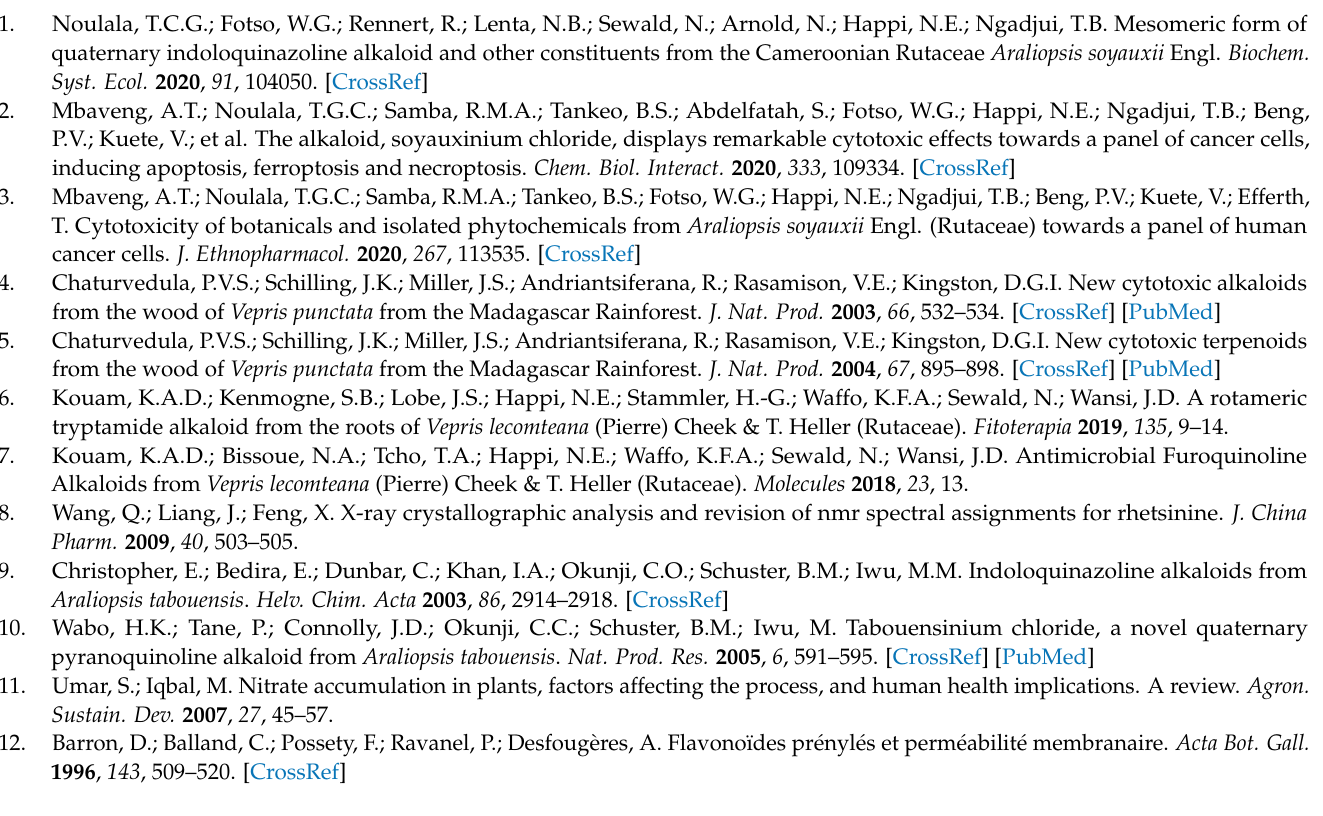
of 3c , Figure S17–S18: 1 H and 13 C-NMR spectra of 3c , Figure S19: ESI-HR Mass spectrum of 4b , Figure S20–S21: 1 H and 13 C-NMR spectra of 4b , Figure S22: ESI Mass spectrum of 5a , Figure S23: 1 H-NMR spectrum of 5a , Figure S24: ESI-HR Mass spectrum of 5a , Figure S25: ESI-HR Mass spectrum of 6a , Figure S26–S27: 1 H and 13 C-NMR spectra of 6a , Figure S28: Mass spectrum of 5 , Figure S29: 1 H spectrum of 5 , Figure S30: Mass spectrum of soyauxinium chloride, Figure S31–S35: 1 and 2D NMR spectra of soyauxinium